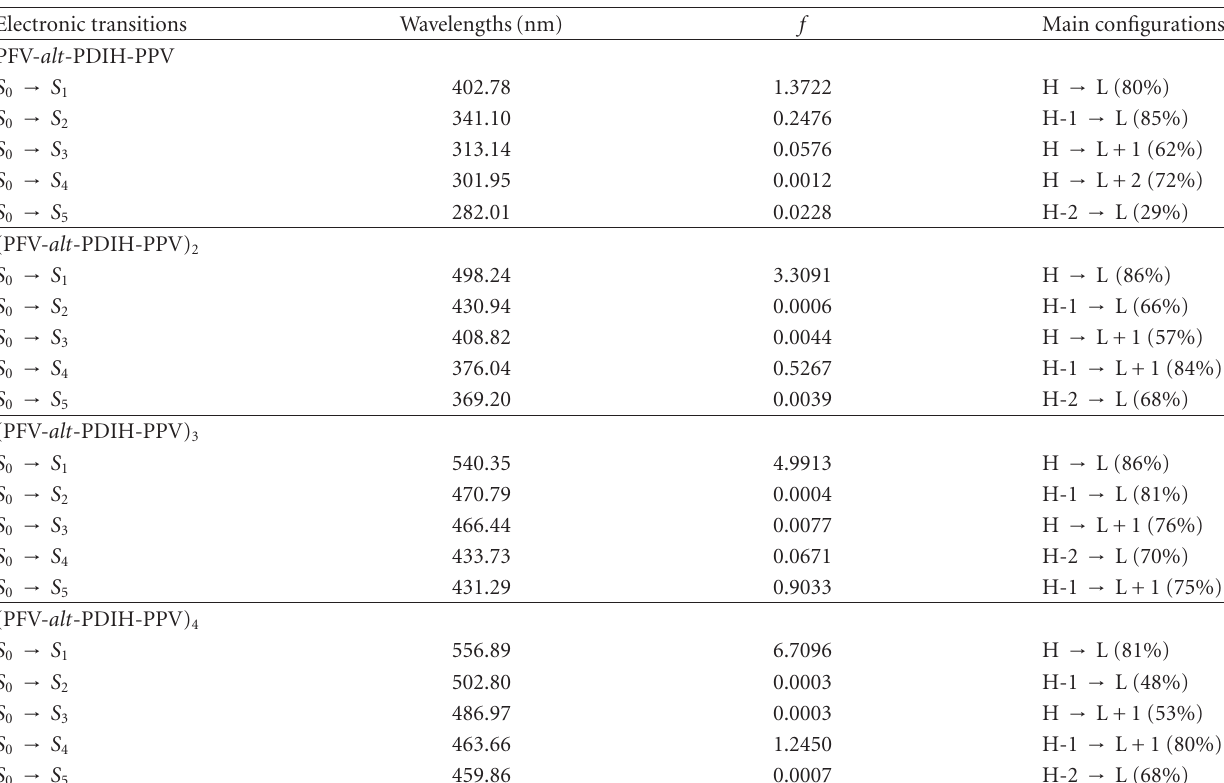
Table 5: Electronic transition data obtained by TDDFT method for PFV- alt -PDIH-PPV ( n = 1–4) at B3LYP/6-31G(d). Electronic